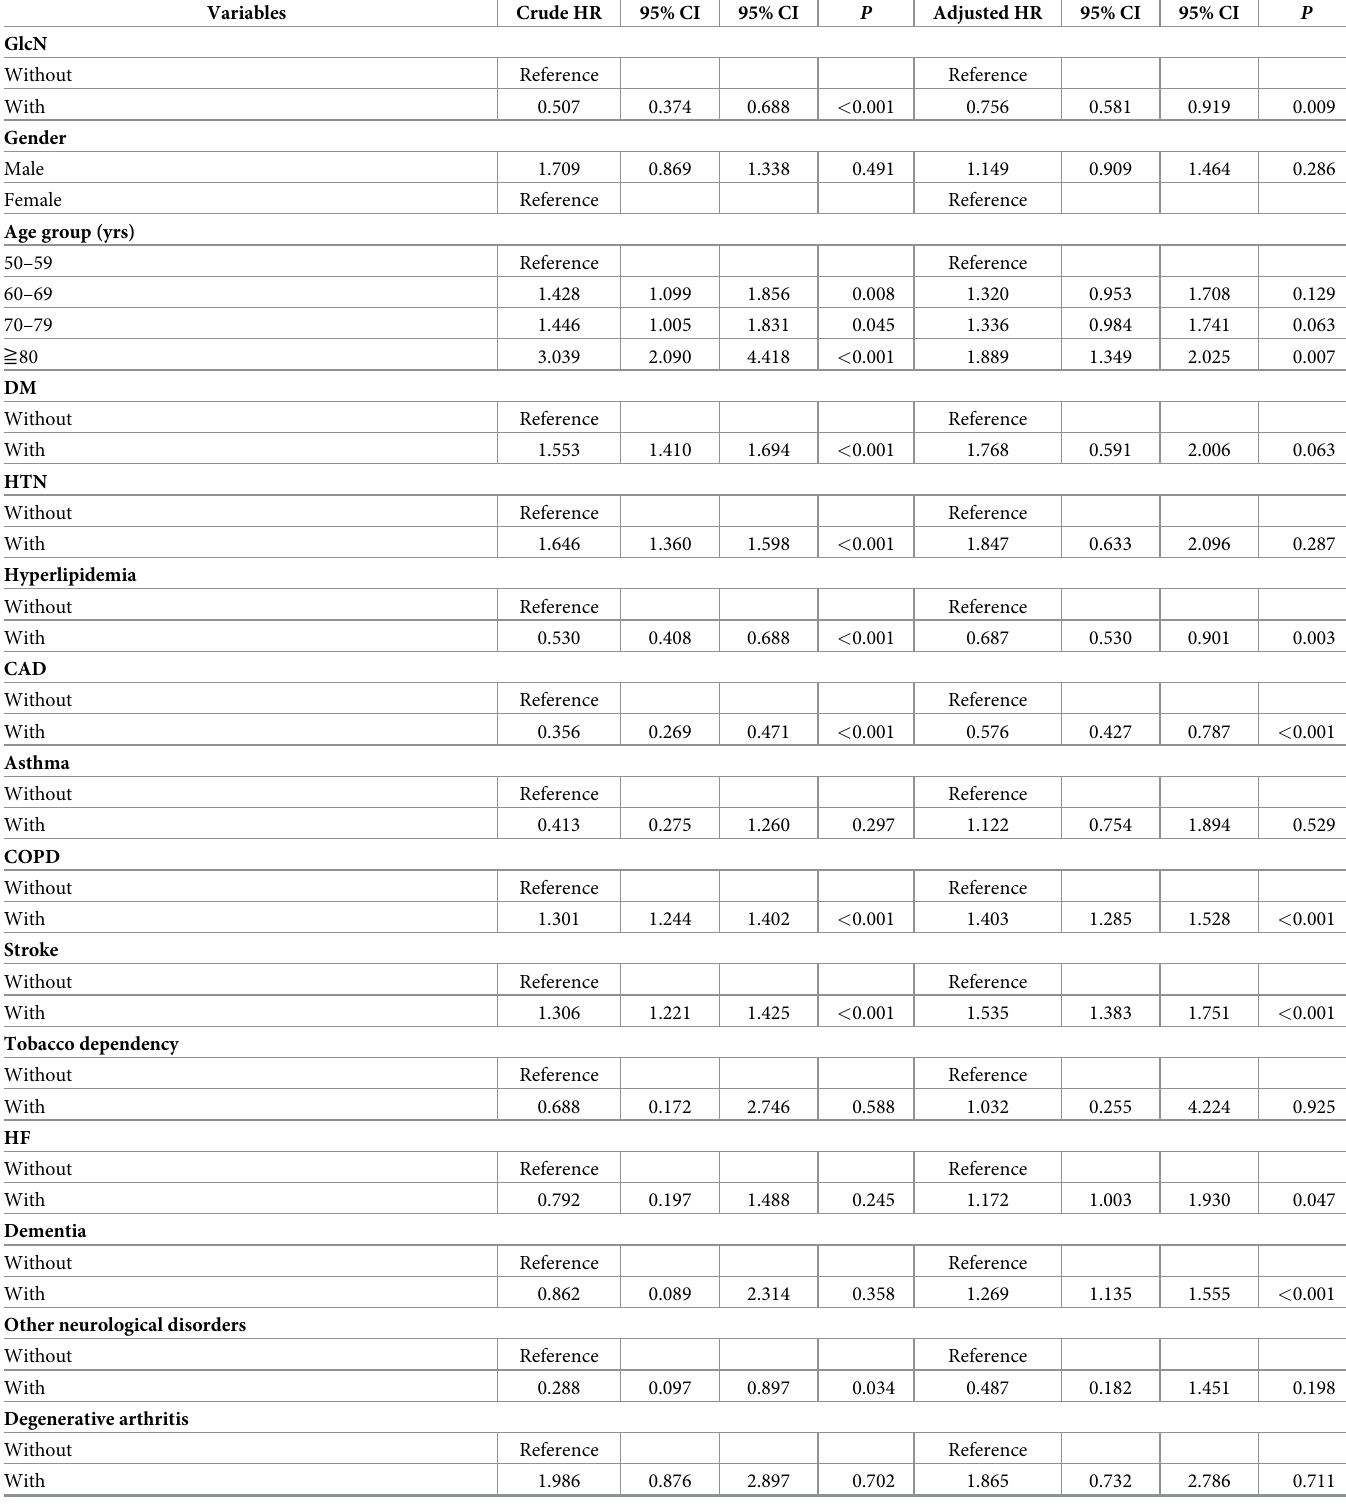
Table 2. Factors associated with the development of AMD as evaluated by Cox